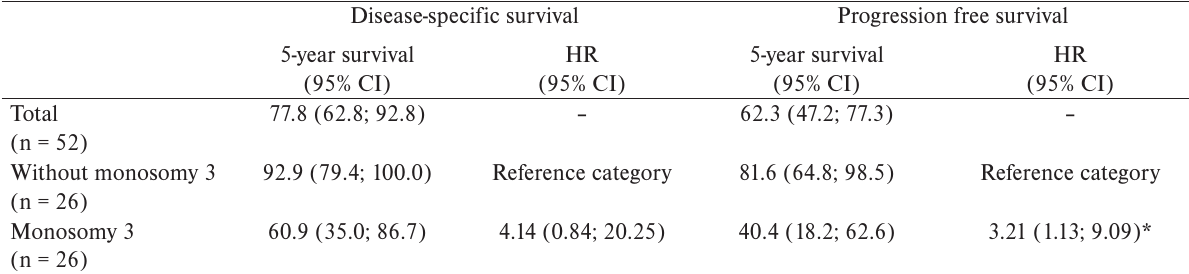
Table 3. Survival by abnormalities of chromosome